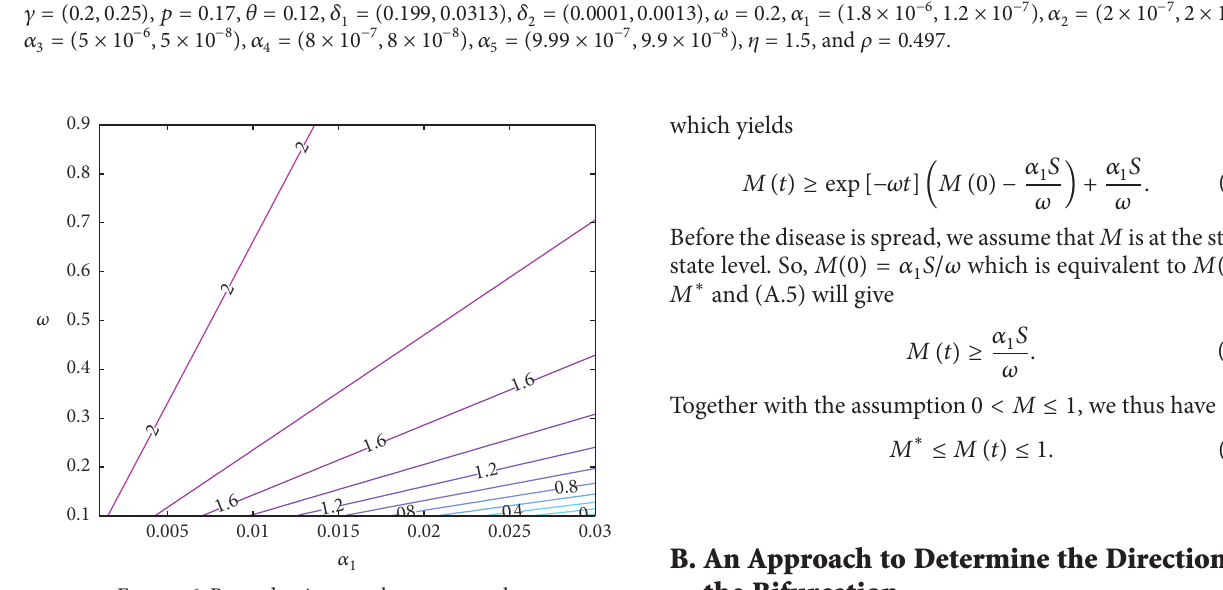
= (1.8 × 10 −6 ,1.2 × 10 −7 ) , 𝛼 1